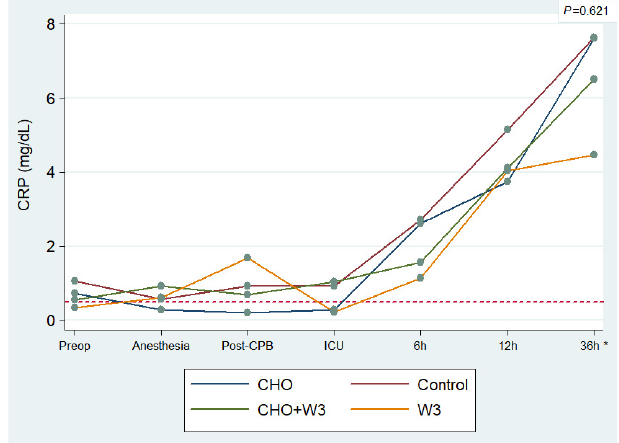
Fig. 7 - Average level of the CRP inflammatory marker per group, taken from seven serial blood tests. *Refers to case-by-case analysis between groups at 36 hours postoperatively (P=0.008). Note: the dotted line indicates the reference value for acute inflammation used by the laboratory.